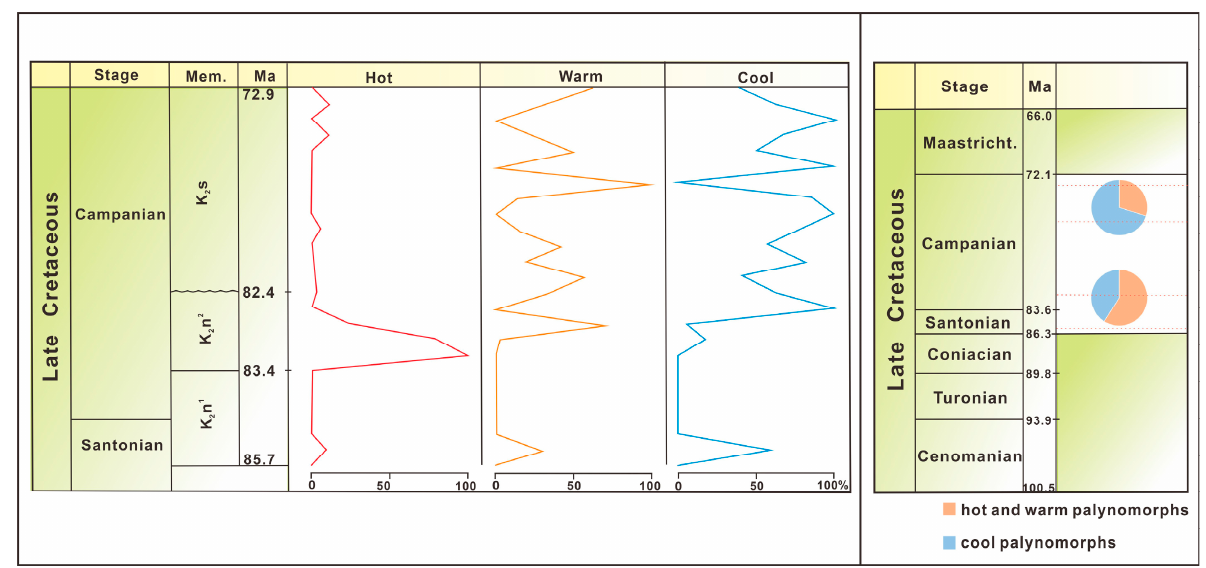
Figure 9. Percentage distribution map of typical thermally adaptable species in borehole ZKY2-1 and a pie chart of typical temperature changes for the Santonian–Campanian stage.